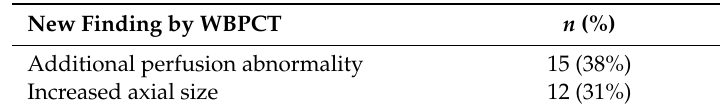
Table 3. Additional findings detected by WBPCT when compared with LBPCT in 39 patients with perfusion abnormality identified by